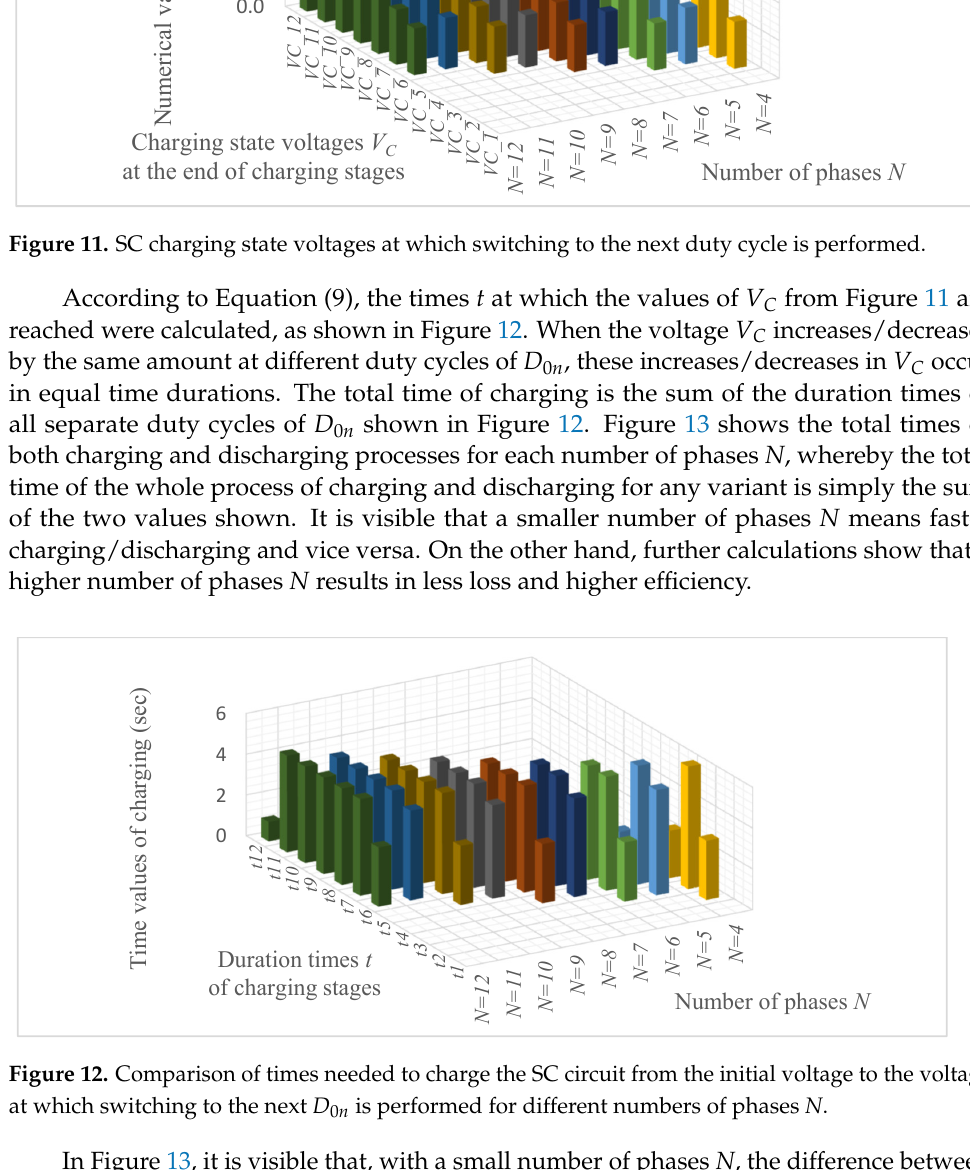
Figure 13. Times of charging and discharging at different numbers of phases N when ∆ V x = 0.1 V. In Figure 13, it is visible that, with a small number of phases N , the difference between the charging and discharging durations is less than 1 s, whereas, with a larger number of phases N , discharging usually takes less time than charging with a difference of up to 2.5 s if ∆ V x = 0.1 V. The maximum peak current at each charging stage with corresponding D 0 n and V out for all variants of the number of phases N could be calculated using Equation (8) when t = 0, and the results are shown in Figure 14. Excluding the very first D 0 n , at any number of phases N , the current peaks for each separate charging stage or D 0 n are equal. As the num- ber of phases N increases, the current peaks decrease more noticeably when comparing the increase in N from four to seven. Furthermore, the current peak decreases less signif- icantly.